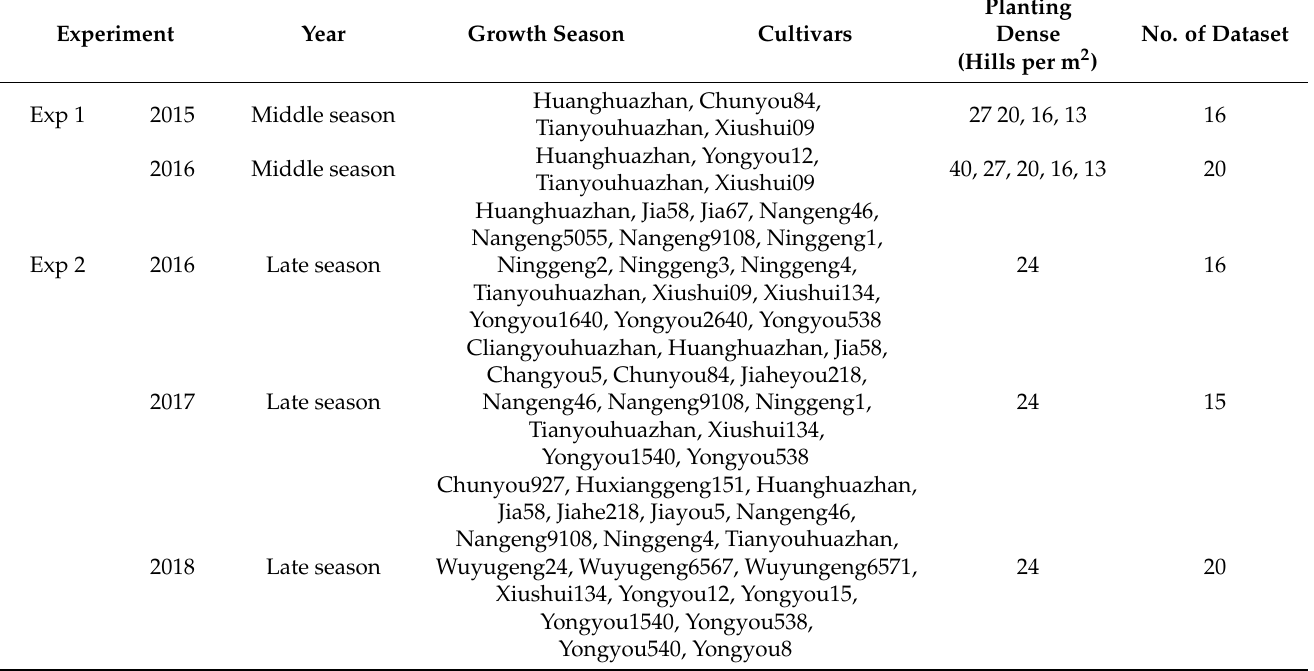
Table 1. Detailed description of the datasets from two rice experiments used in the current study. Experiment Year Growth Season Cultivars